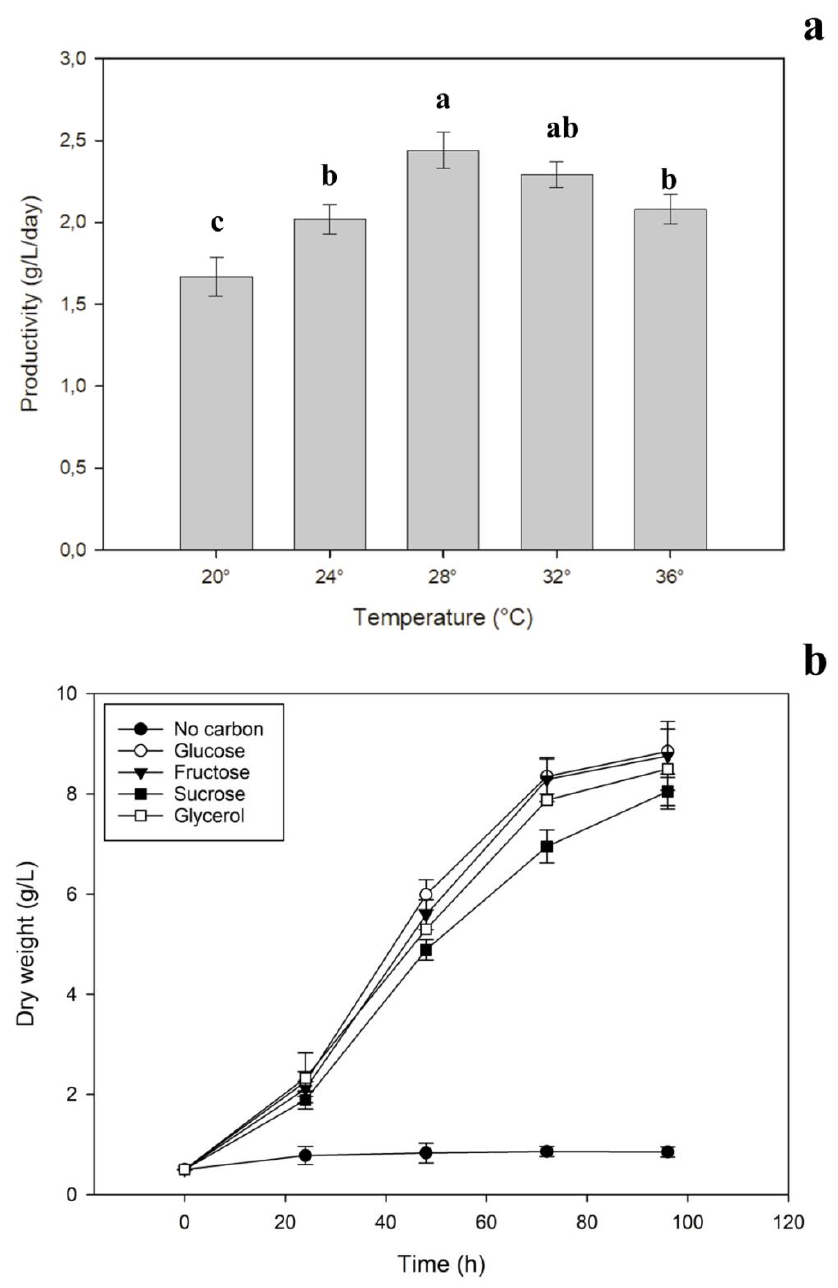
Figure 2. Productivity and growth curves of A. mangrovei RCC893 at different growth temperatures ( a ) and organic carbon source ( b ) on an orbital shaker. Values are reported as mean ± SD. Different letters in the same graph show the statistical difference among the treatments.